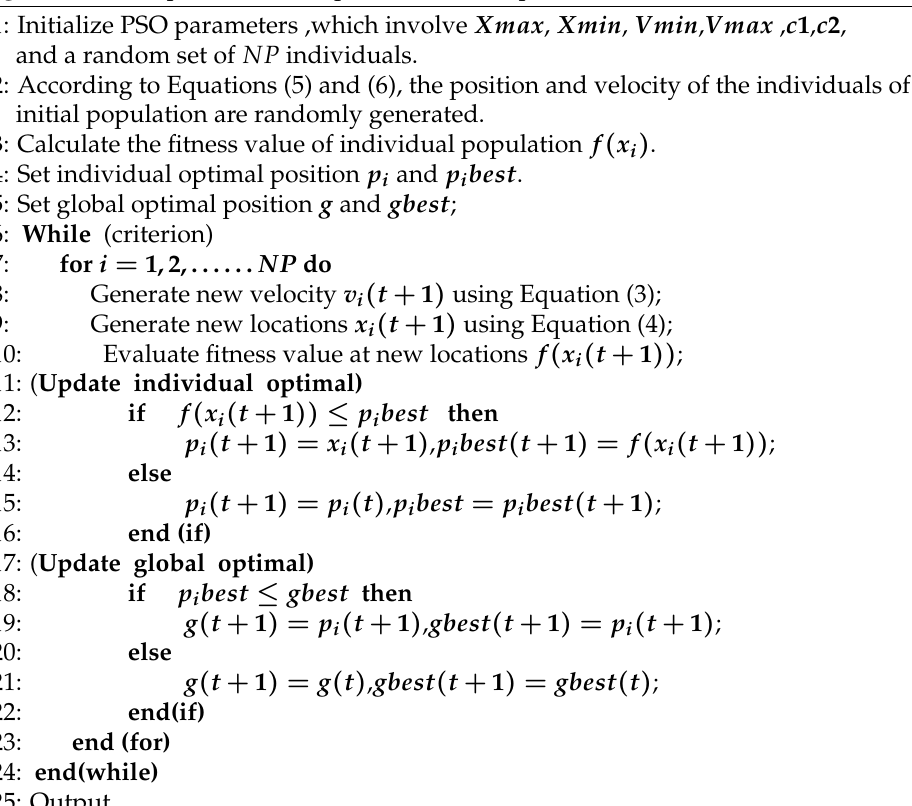
Algorithm 1 The pseudocode of particle swarm